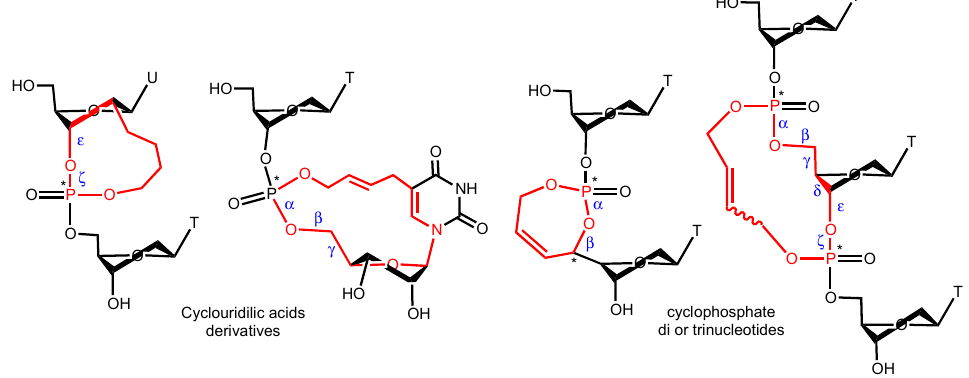
Figure 4. Cyclophosphotriesters obtained by RCM (* newly generated asymetric center).